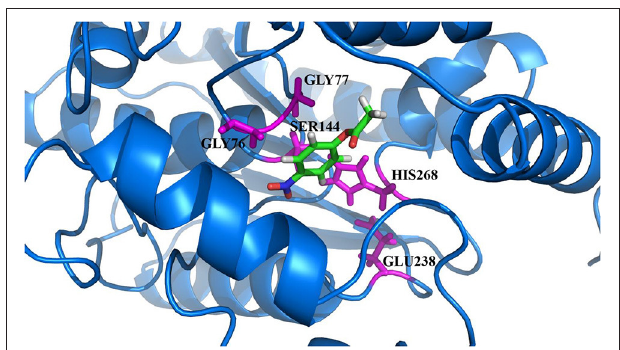
FIGURE 5 | 3D docking model of the preferred substrate, 4-nitrophenol acetate. The catalytic site residues of 7N9 are highlighted in magenta with the substrate placed in the center.